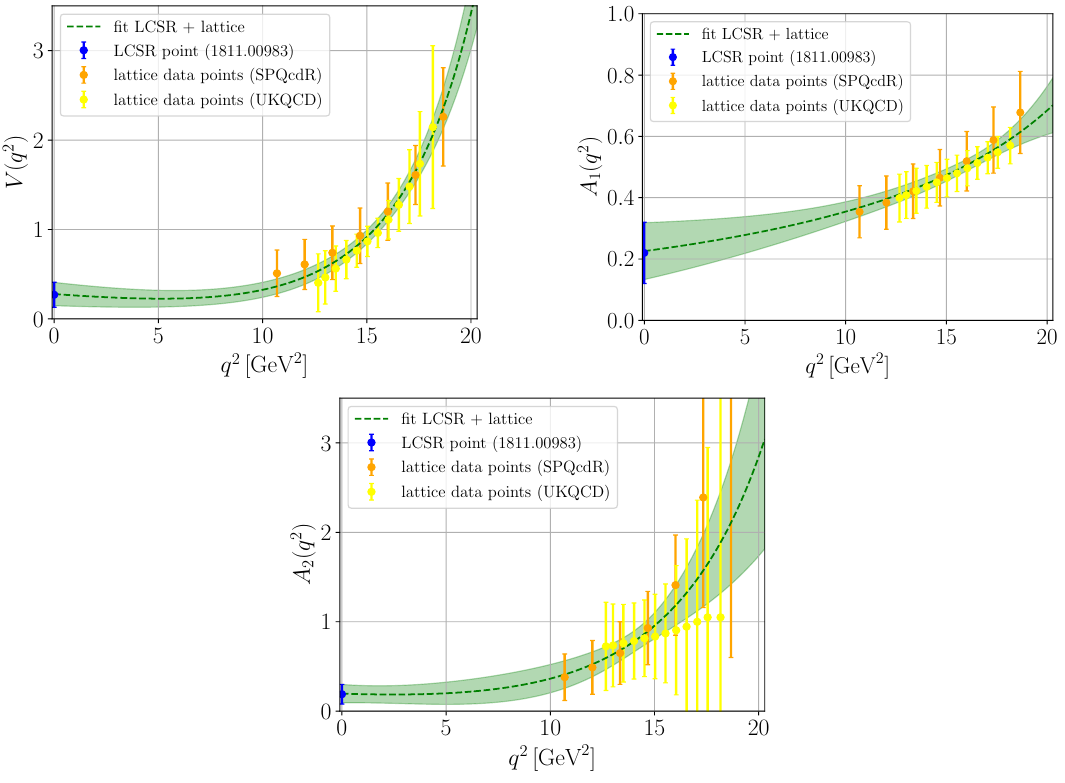
Figure 3 . B → ρ form factors V , A 1 and A 2 . LCSR data [41] (blue points), lattice data [68] (orange and yellow points) and our fit results (green dashed line) and their 1 σ uncertainties (green